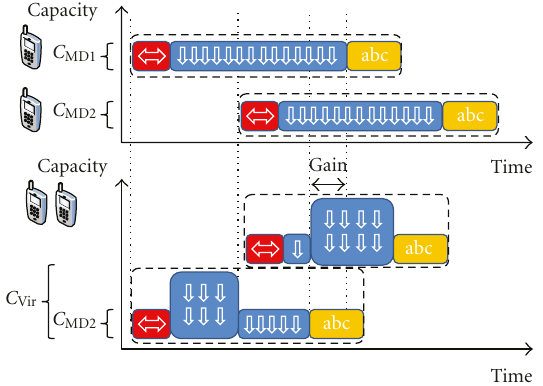
Figure 4: Overlapping Page Download Phases. The figure shows the virtual capacity in the cooperative and noncooperative web browsing when the page download phases on the two devices are overlapping with each other. The virtual capacity is increased only when the page download phases of the two devices are not overlapping. Comparing this figure with Figure 3, you can see that the gain in the cycle duration is smaller due to the fact that the devices are not cooperating all the